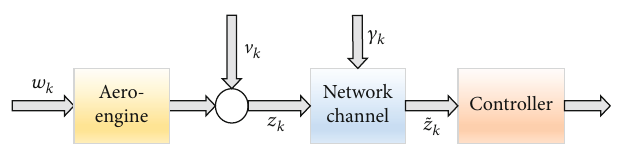
Figure 2: Network transmission